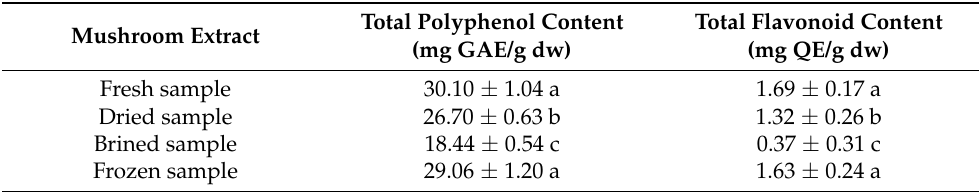
Table 2. Total polyphenol and flavonoid contents in the methanolic extracts obtained from different tropical black bolete samples.